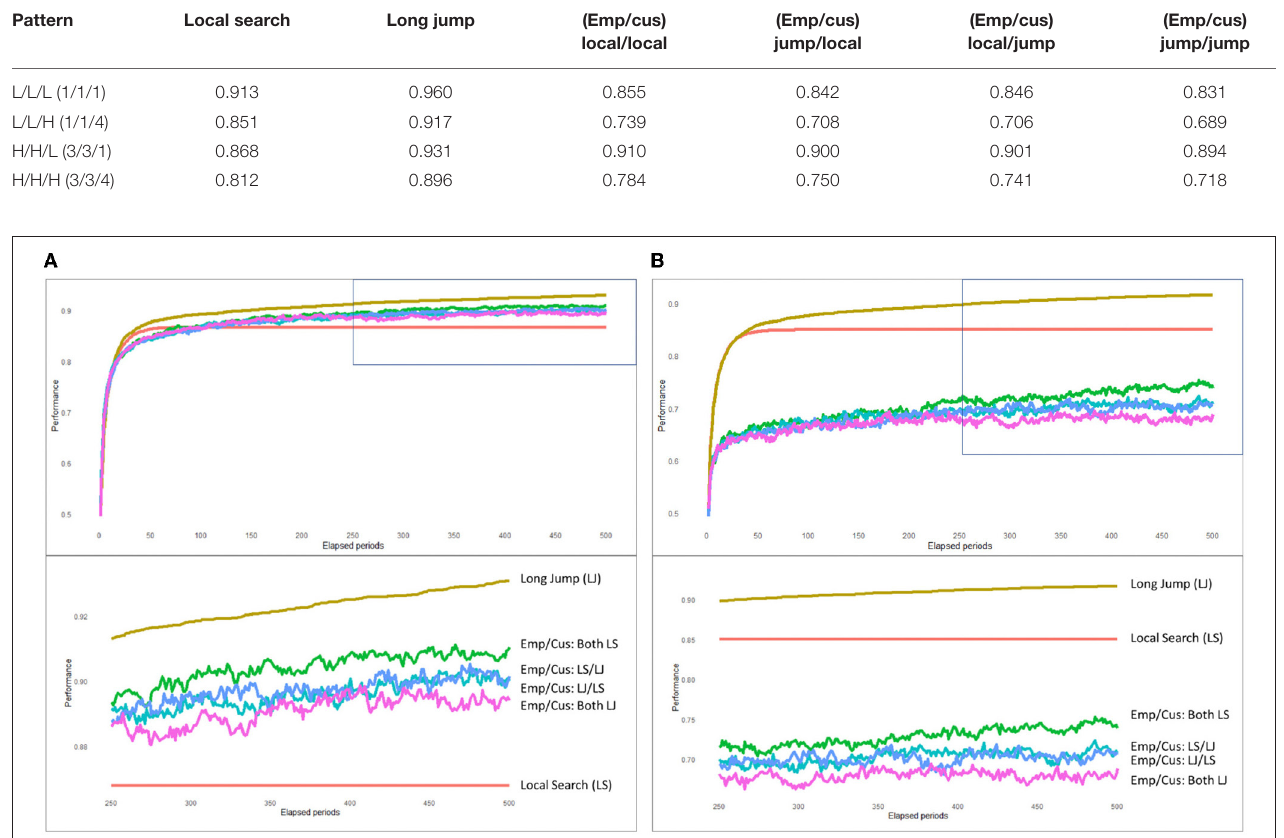
FIGURE 3 | (A) L/L/H (low/low/high) case. (B) H/H/L (high/high/low)